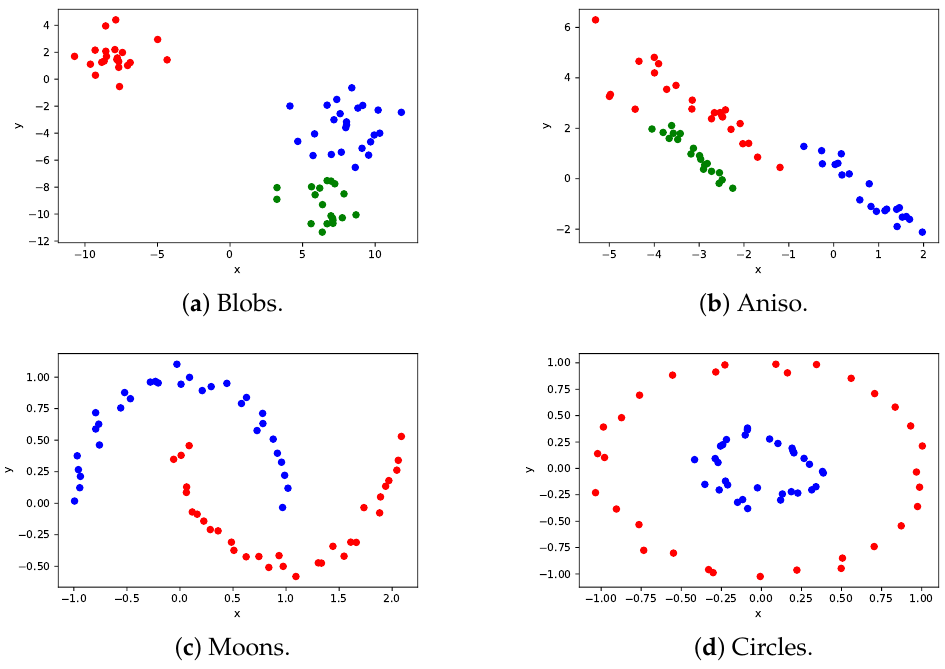
Figure 3. Clustering results of the proposed method. Data points having the same color belong to the same cluster.